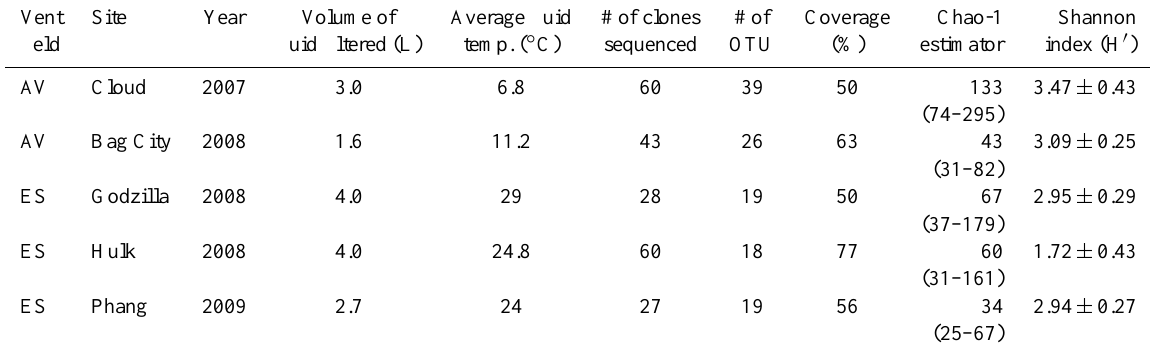
Table 2. Bacterial 16S rRNA gene clone libraries information and OTUs richness (Chao-1) and diversity (Shannon) estimates. Sequences with a similarity ≥ 97% are considered the same OTU. Uncertainties for the Chao-1 estimator (in brackets) and the Shannon index represents 95% confidence